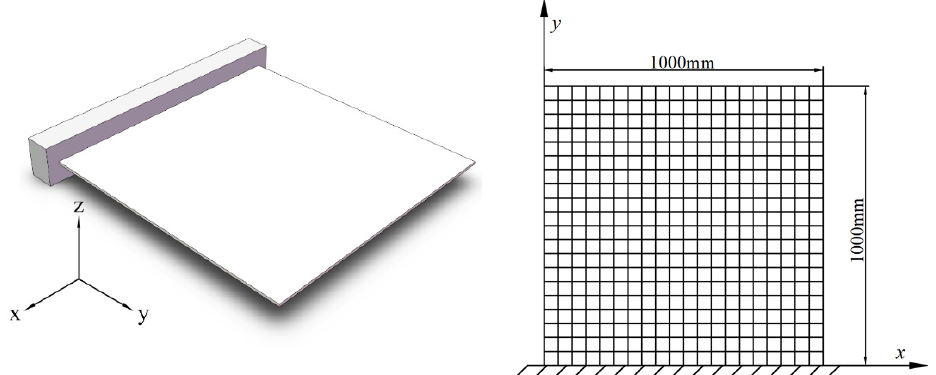
Figure 9. The plate fixed at one end ( left ) and its mesh elements ( right ).